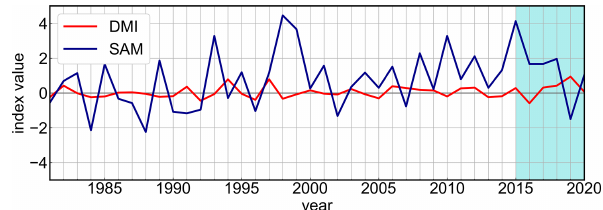
Figure 10. Annual observations of Southern Annular Mode (SAM) and dipole mode index (DMI) between 1981 and 2020. DMI cap- tures the east-to-west sea surface temperature gradient across the tropical Indian Ocean. Years 2015–2020 are shaded in turquoise, representing our study period. SAM data are from Marshall (2018), and DMI data are available at https://stateoftheocean.osmc.noaa. gov/sur/ind/dmi.php (last access: 29 June